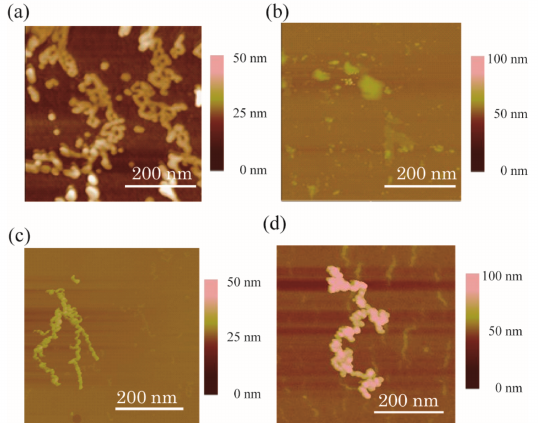
Figure 3. AFM images of the samples after incubation with Ca 2+ for 3 h with ( a ) MYC alone; ( b ) MYC and calmyc; and ( c ) MYC, calmyc, and calpain I and ( d ) after incubation with Ca 2+ for 24 h with MYC, calmyc, and calpain